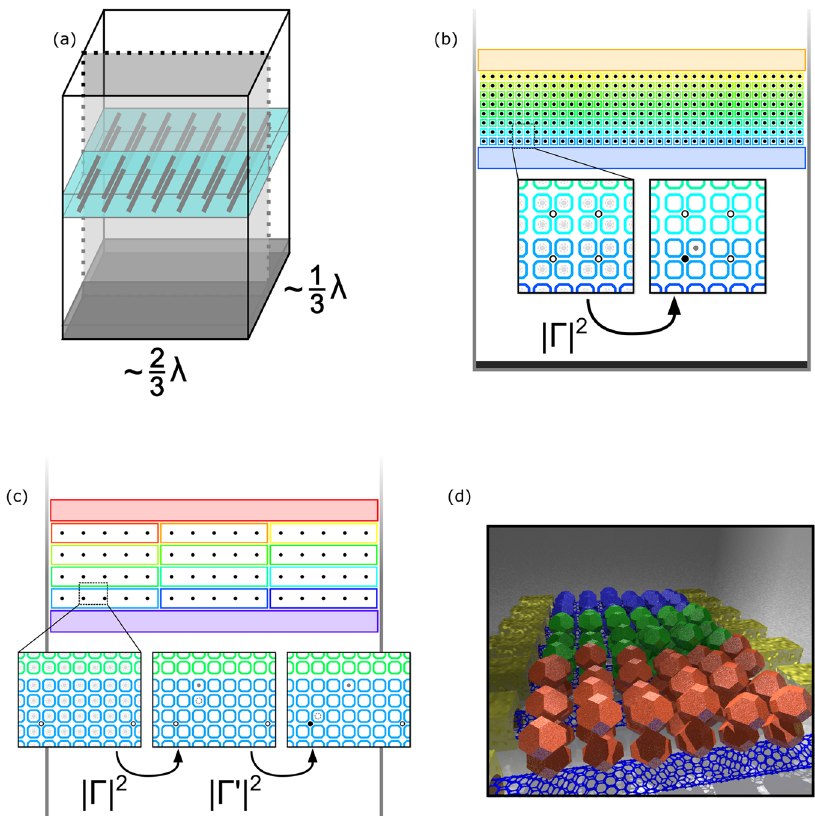
Fig. 6 Physical realization of photodetector. a The device as situated in the waveguide. The teal region is the active area of the device containing absorbing and measuring components. The dark grey region represents a mirror at the end of the waveguide. The vertical plane with a dotted outline shows the cross section taken for depiction of the two device con fi gurations shown in b , c . In these the quantum dots (QDs) are shown as colored squares, with the carbon nanotube (CNT) measurement channel cross section shown as a black circle. λ is the wavelength of the incoming photon. b The most direct realization of the design. The incoherent process in this case (depicted in the inset with rate Γ ) is the separation of the QD exciton, depicted as a solid gray circle for the electron and a dotted line circle for the hole, with a carrier (in this case the hole) migrating into the CNT. The fi eld due the remaining carrier alters the conductivity of the CNT (indicated by the black fi lling), which is detected as an absorption event. c A transduction process comprising multiple steps. The fi rst part of the incoherent decay is the separation of the exciton (rate Γ ), followed by migration to adjacent quantum dots (rate Γ 0 ). A fi eld near the carbon nanotube drives the carriers apart, with one arriving at a dot adjacent to the tube, where it modulates the CNT conductivity. d A more detailed representation of the CNTs with the QD functionalization is